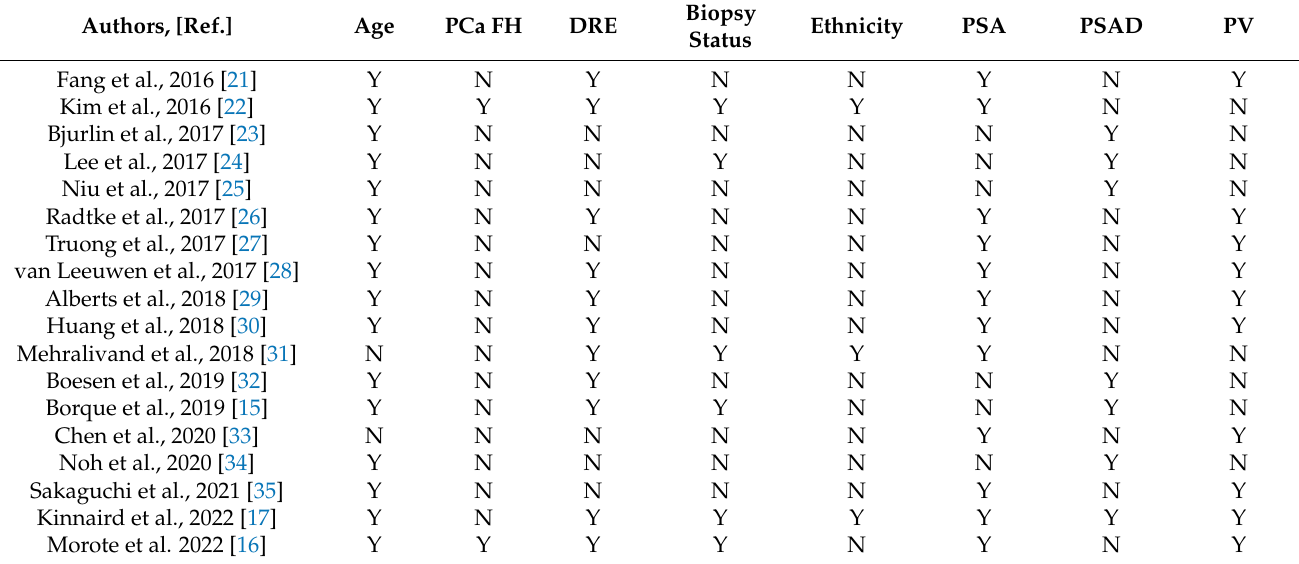
Table 2. Clinical predictors included in developed MRI-PMs for clinically significant prostate cancer.